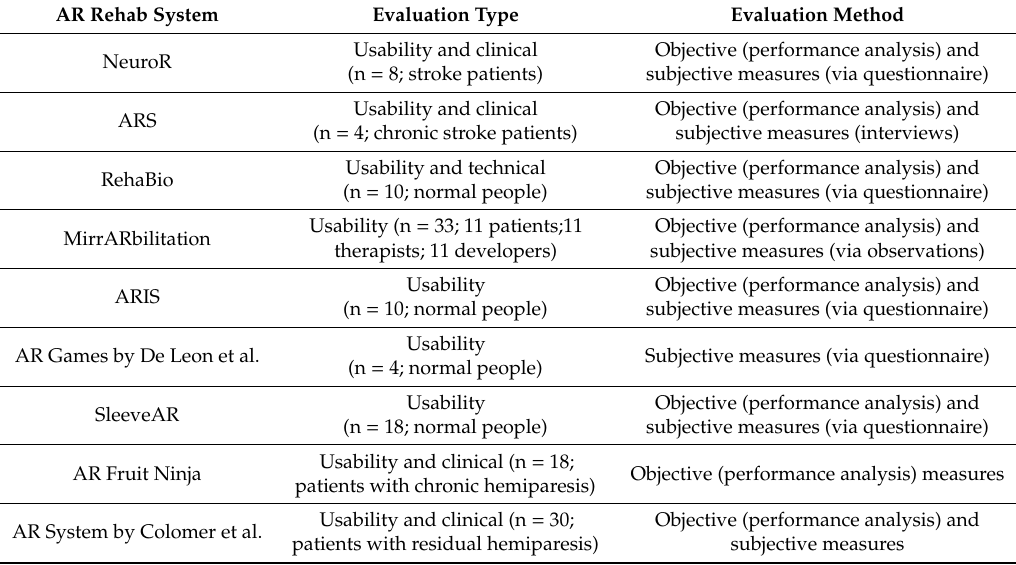
Table 4. Evaluation of the AR Rehab Systems